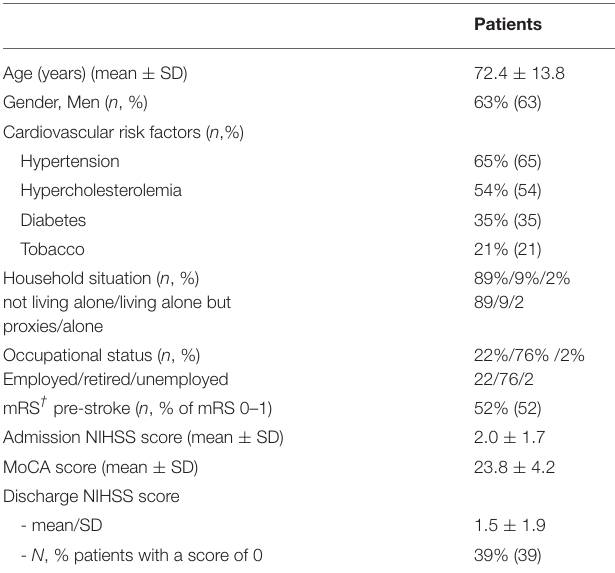
TABLE 3 | Characteristics of the validation cohort from the Bernese registry ( n = 49).